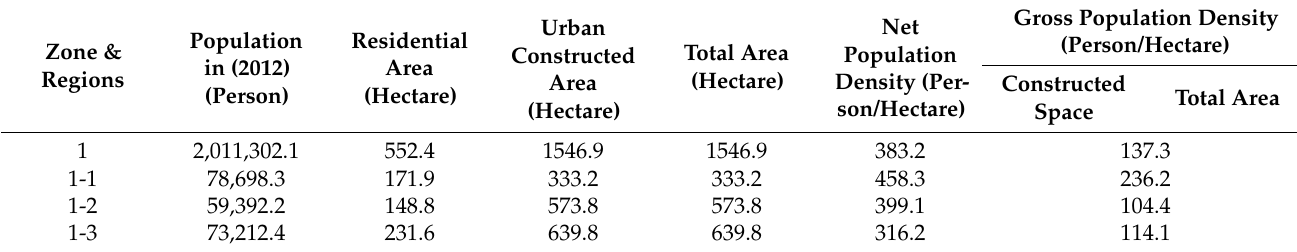
Table 14. Population density and land use characteristics of municipal Zone one in Tabriz, Iran.